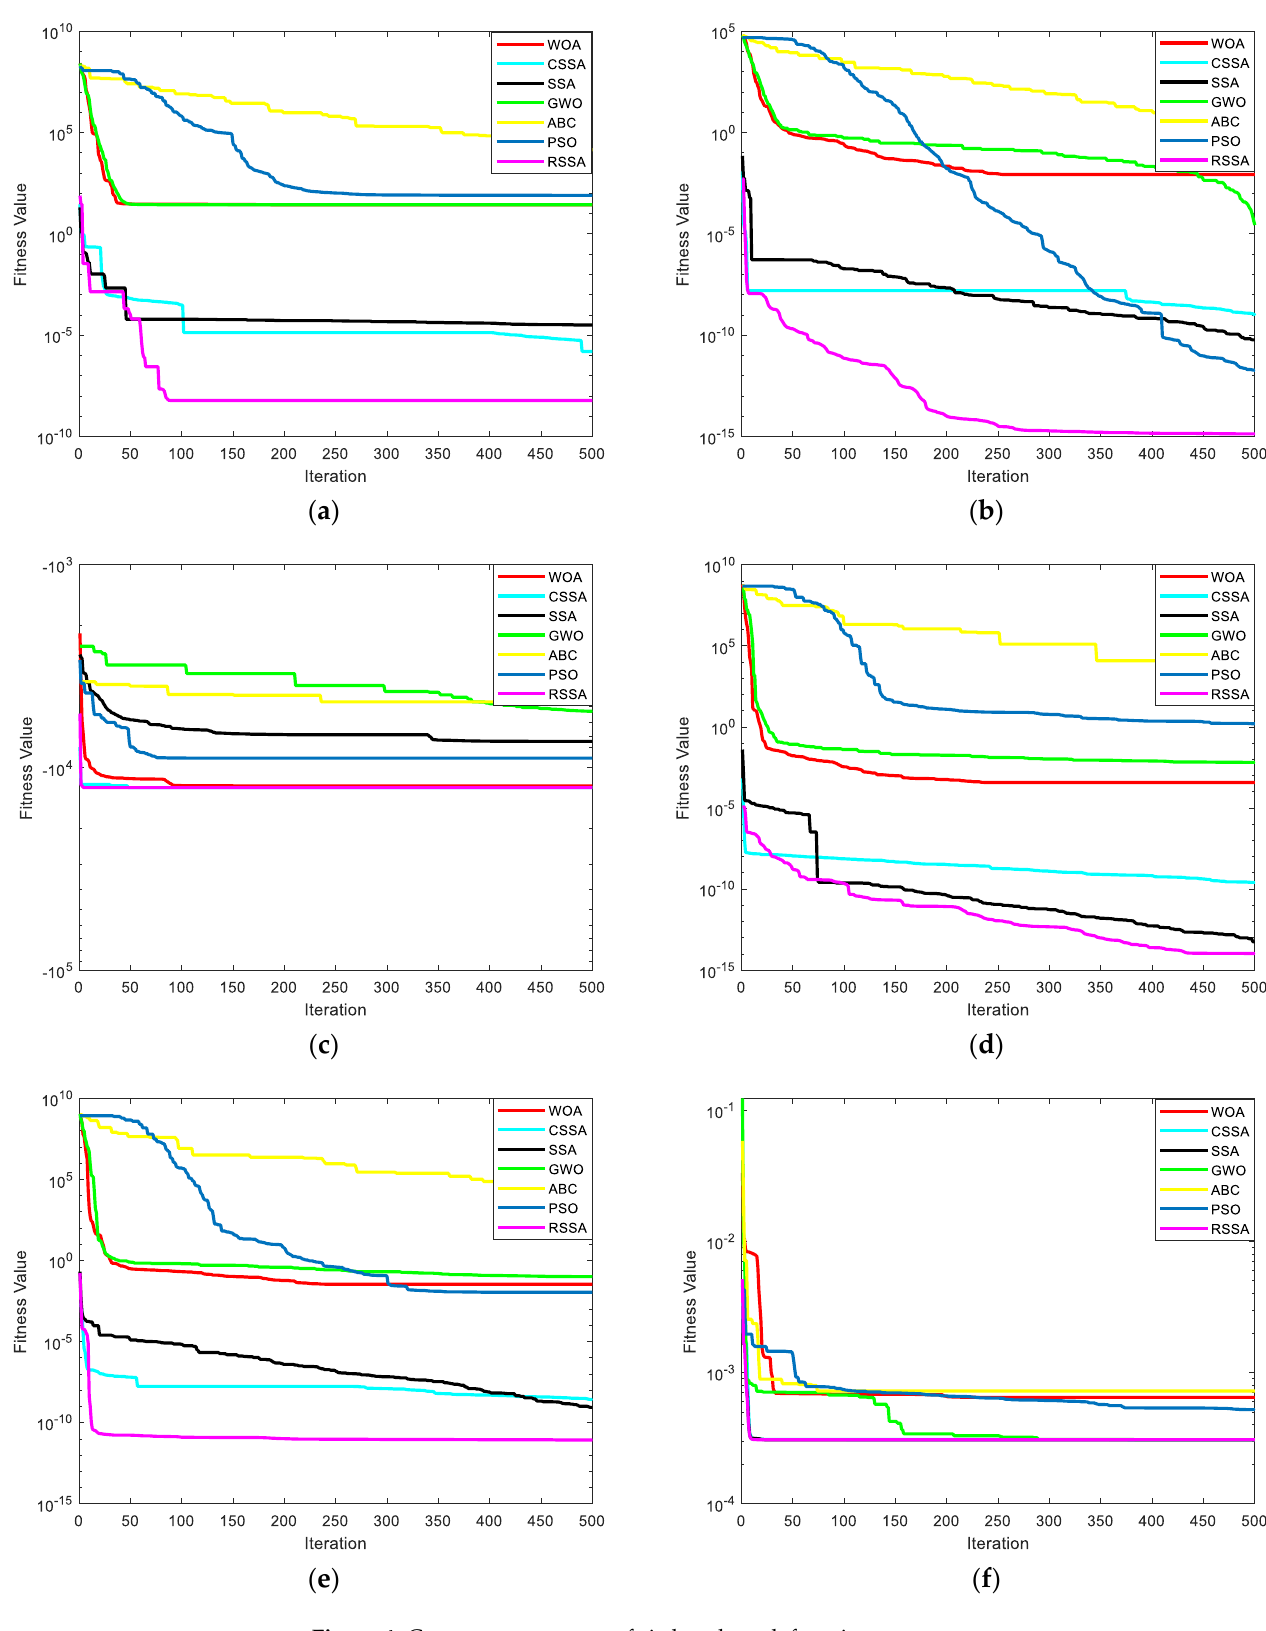
Figure 4. Convergence curves of six benchmark functions.